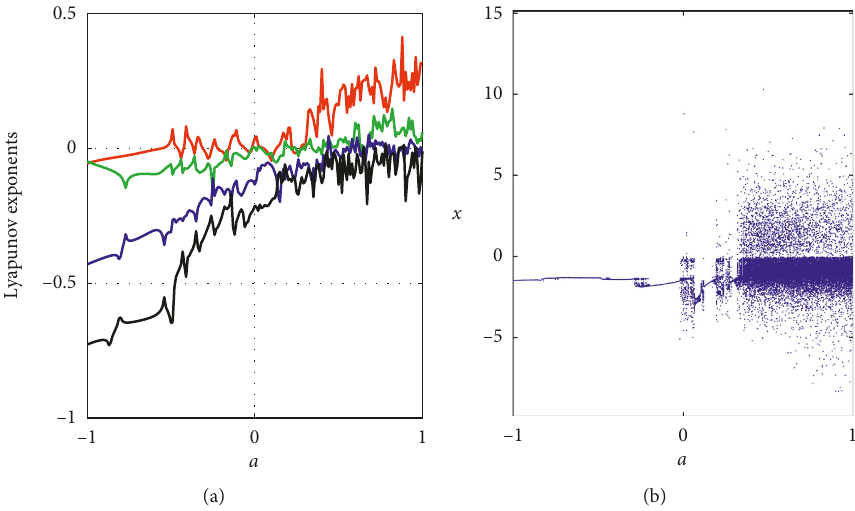
Figure 3: Lyapunov exponents and bifurcation diagram for increasing parameter a (the five LE5 is out of